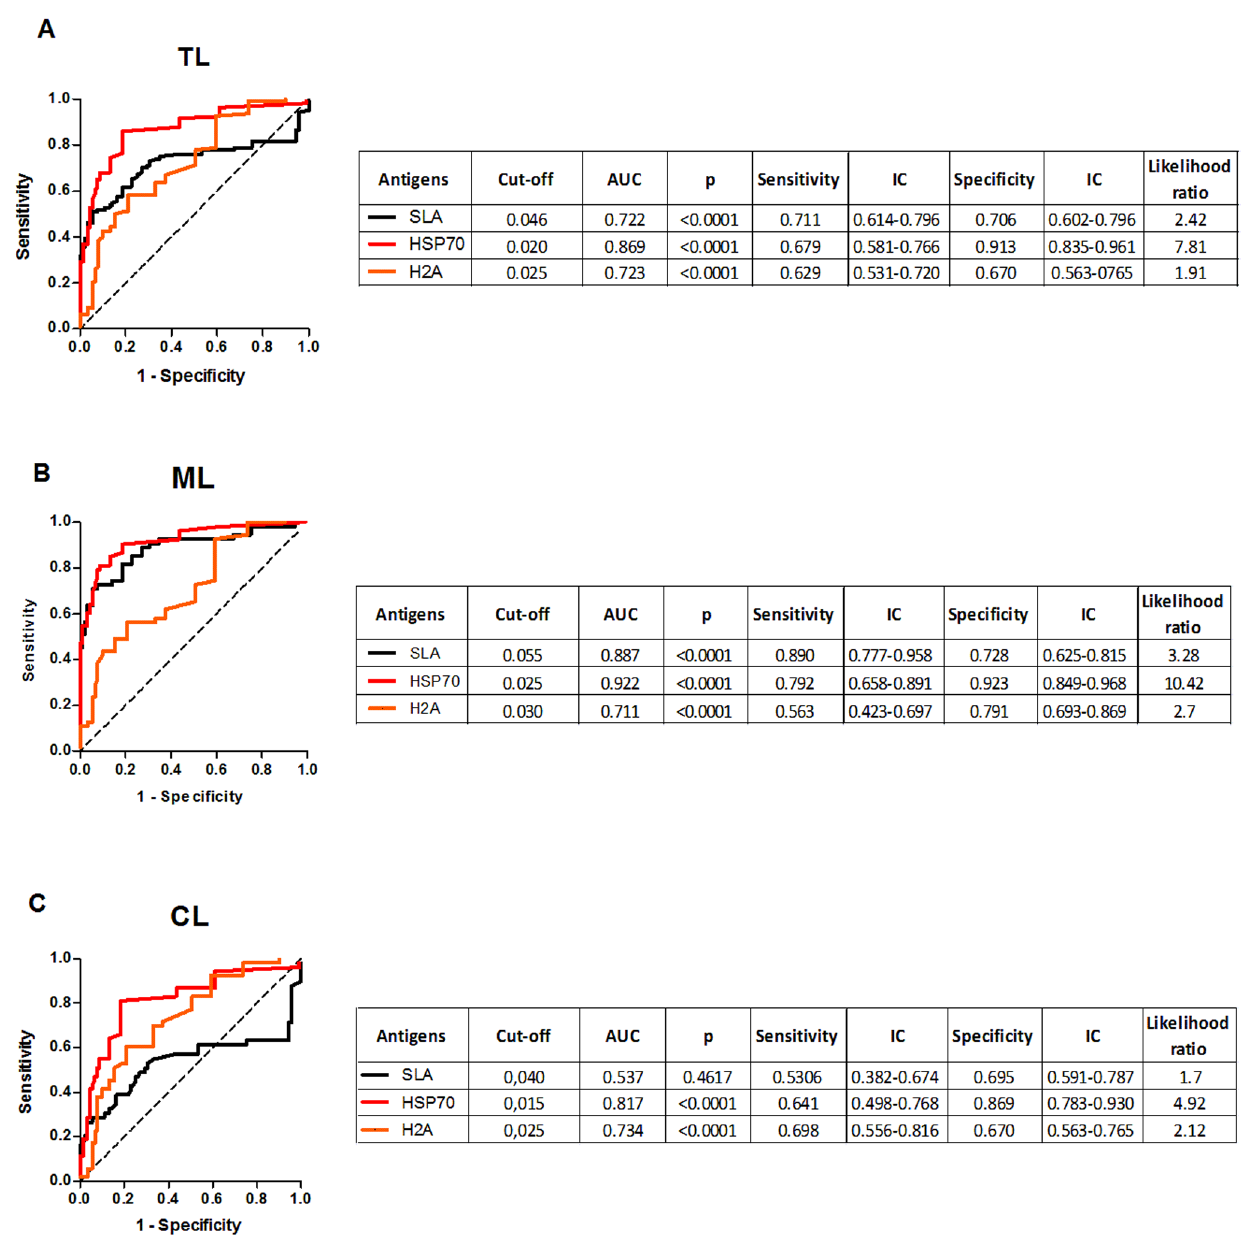
Figure 4. ROC curve of antibody levels predict the positivity thresholds against rHSP70 and rH2A. ROC curves were constructed using data obtained with sera from TL (n=102) (A), ML (n=53) (B) and CL (n=49) as patients and sera from individuals with Chagas’ disease (n=30), SLE (n=10), leprosy (n=30) and tuberculosis (n=22) as negative control. The solid lines represent the area under the curve and the dotted line represents the identity line curves. The tables show the detailed information obtained from each ROC curve (cut-off values chosen, area under the curve, the p values, and the sensitivity and specificity with a confidence interval of 95% and the likelihood ratio).